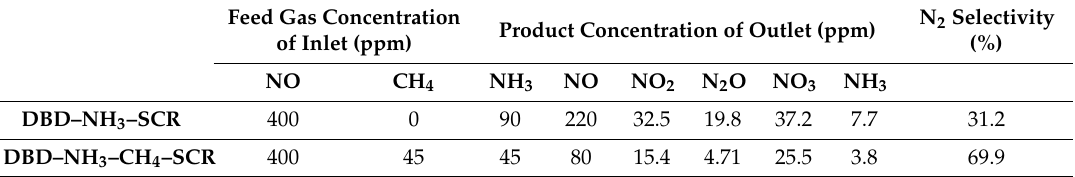
Table 1. The N 2 selectivity and concentration of feed gas as well as products at outlet. Feed Gas Concentration of Inlet (ppm)